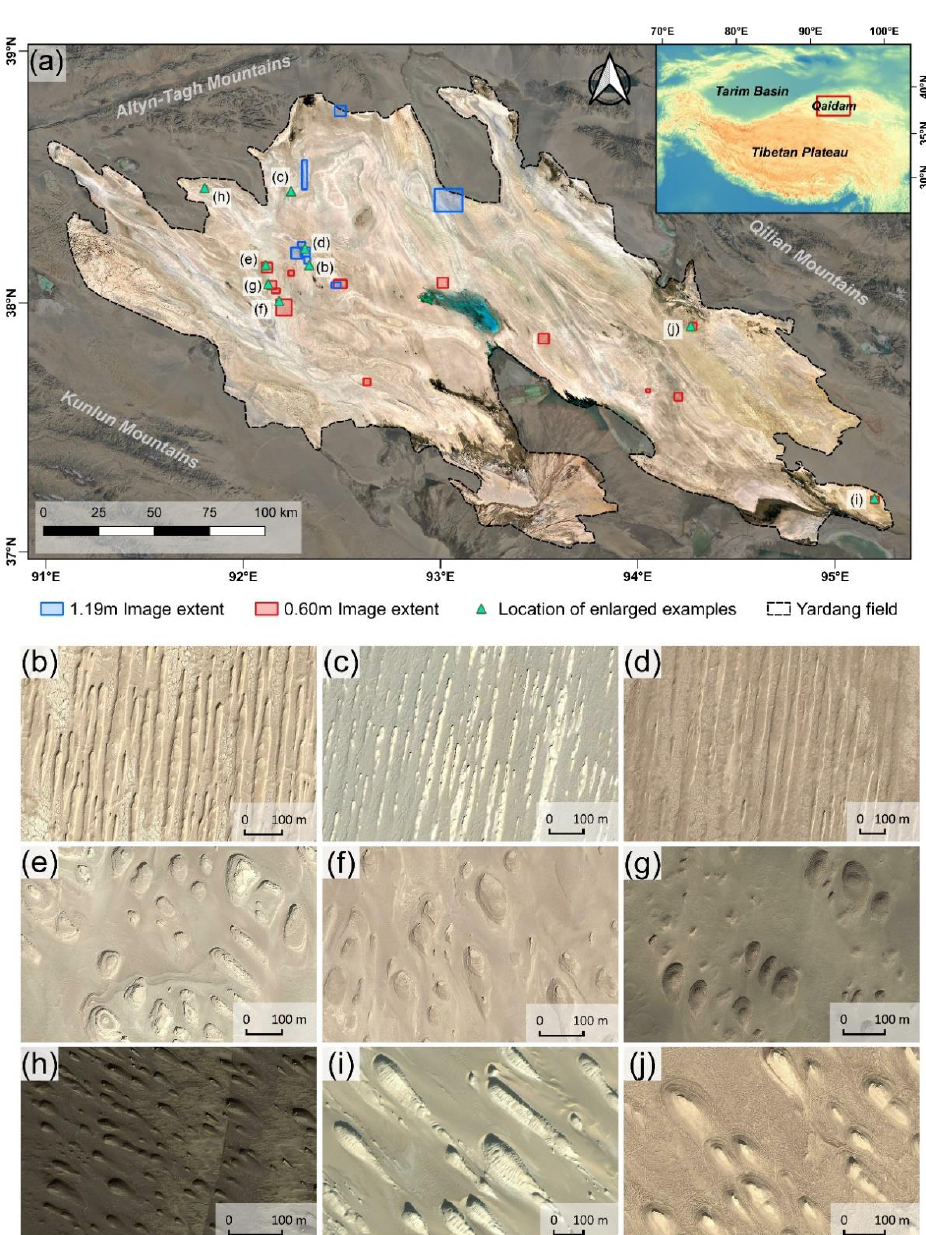
Figure 1. The study area and examples of yardangs. ( a ) Geographical settings of Qaidam Basin and locations of the original Google Earth image subsets. Images with resolution of 0.60 m and 1.19 m are displayed in red and blue rectangles, respectively. Enlarged images (true color) displayed examples of three types of yardangs, which are ( b – d ) long-ridge yardangs, ( e – g ) mesa yardangs and ( h – j ) whaleback yardangs.